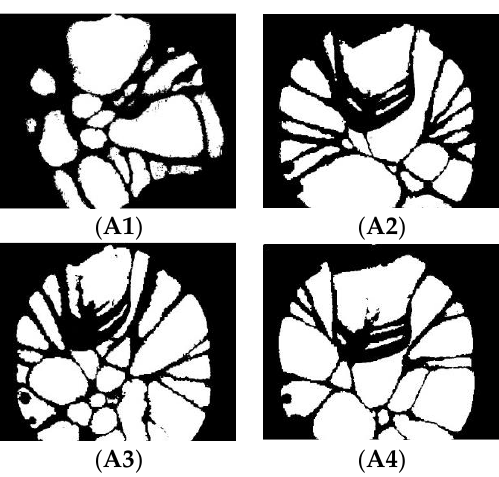
Figure 8. A1-A4 are segmented images of a-d obtained by Otsu-based DPSO method